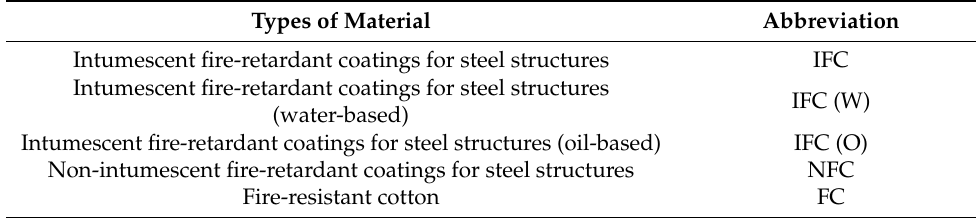
Table 1. Abbreviation comparison of the materials’ names.